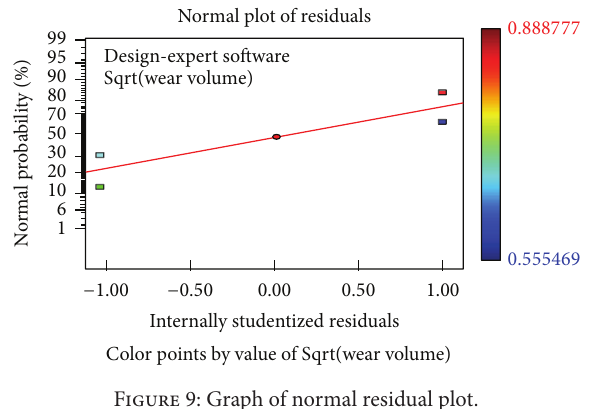
Figure 9: Graph of normal residual plot.